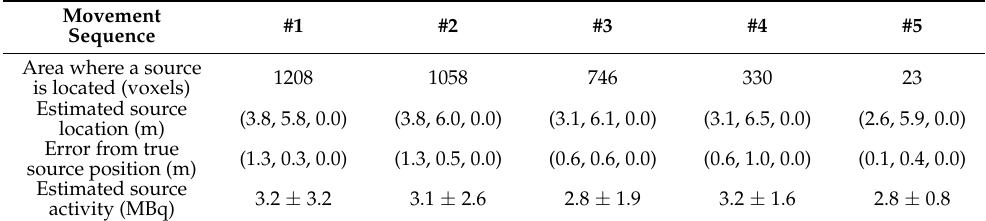
Table 5. Summary of the estimated source intensities and locations obtained by Path II in the integrated simulation